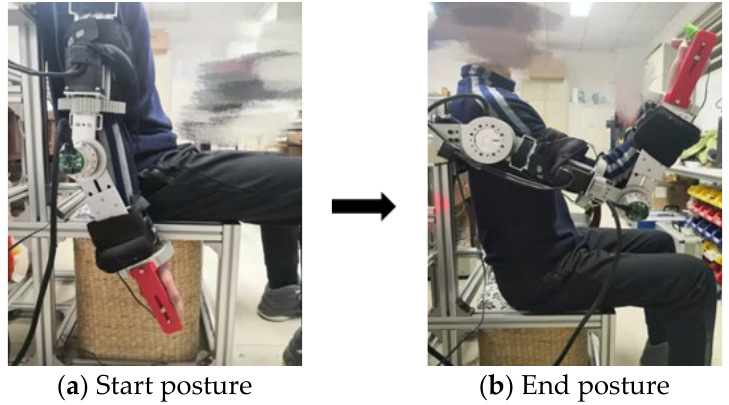
Figure 18. Upper-limb exoskeleton experiment platform.